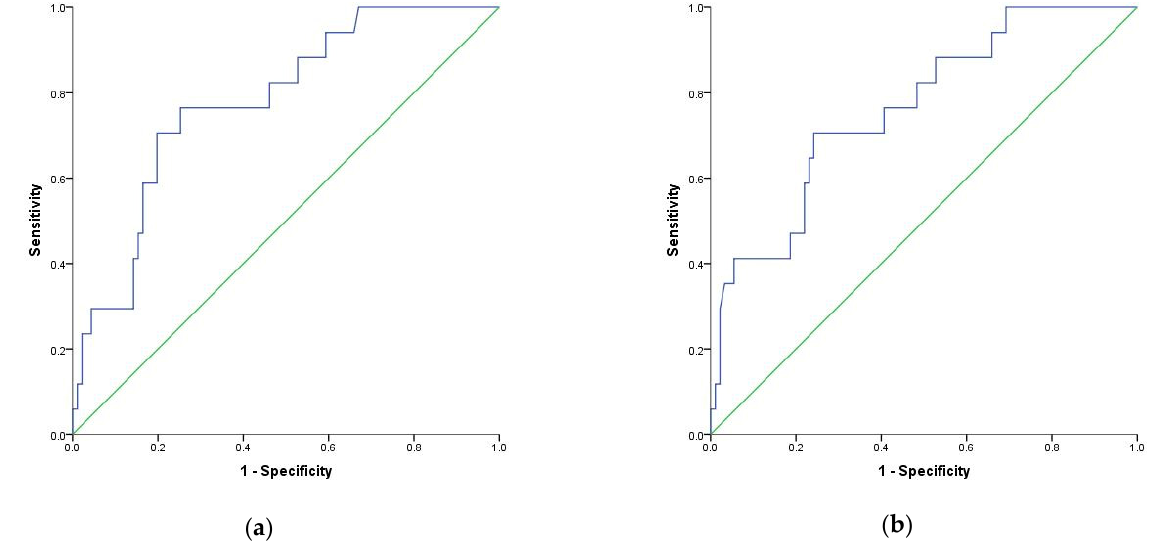
Figure 5. Receiver operating characteristic (ROC) curve for logistic regression models: ( a ) MLR (above or below 0.69) as a prognostic factor of mortality adjusted to age, sex and comorbidities index; ( b ) SIRI (above or below 2.2) as a prognostic factor of mortality adjusted to age, sex and comorbidities.